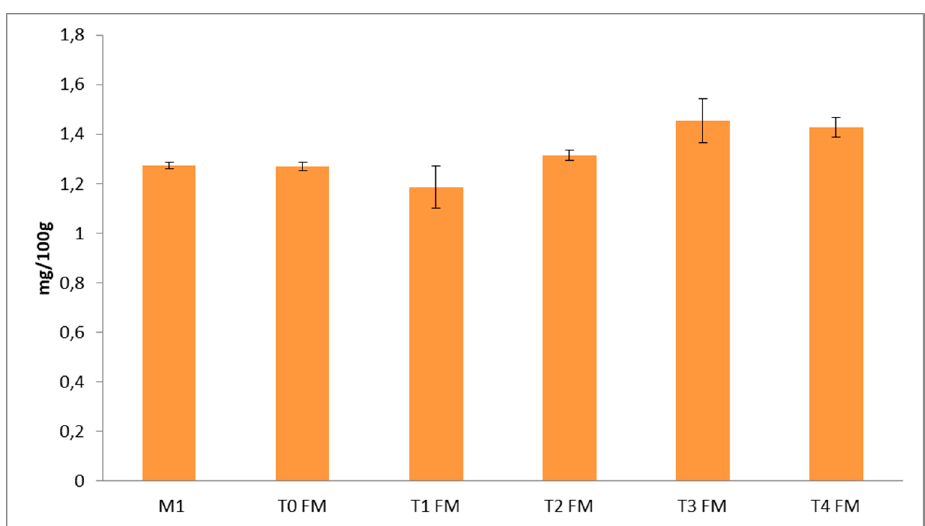
Figure 3. Free phenol content determined by HPLC-DAD in unfermented (M1) and fermented (FM1) millet flour at different withdrawals (T0-T4). Data are expressed in mg/100 g of dry weight as a mean of three different extractions.